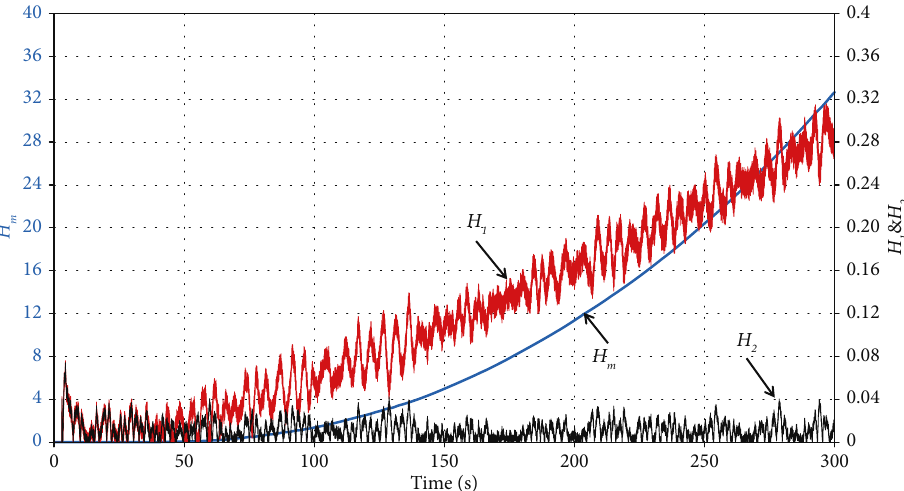
 when had a drift fault. P 1 m